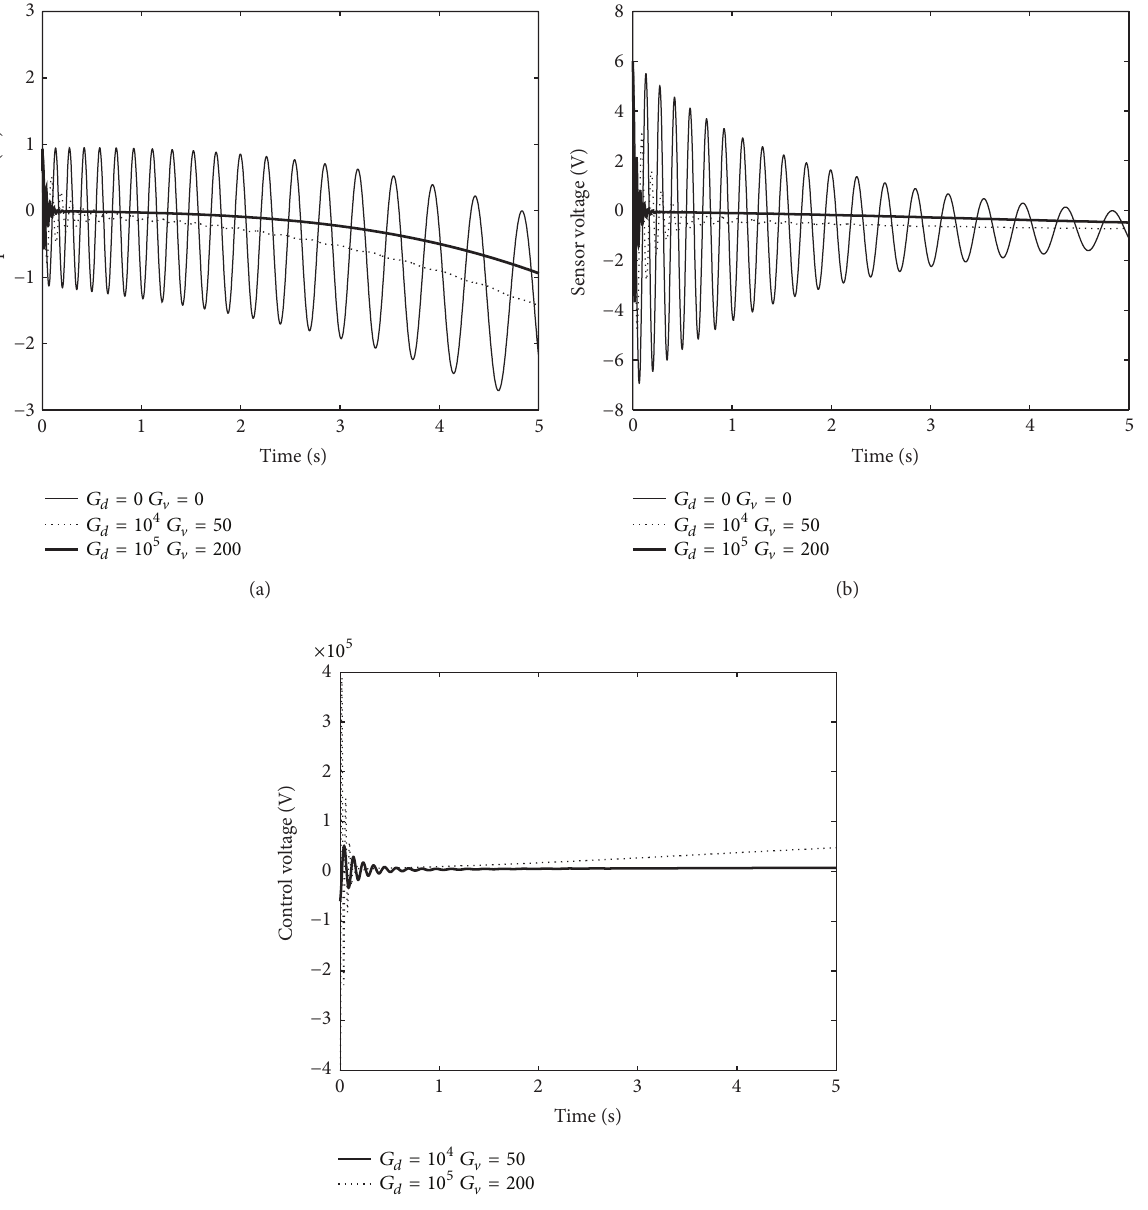
Figure 5: Tip deflection (a), sensor voltage (b), and control voltage (c) of the arm under different control gain when 𝐿(𝑡) = 1 + 0.2𝑡 , 0.2𝜋